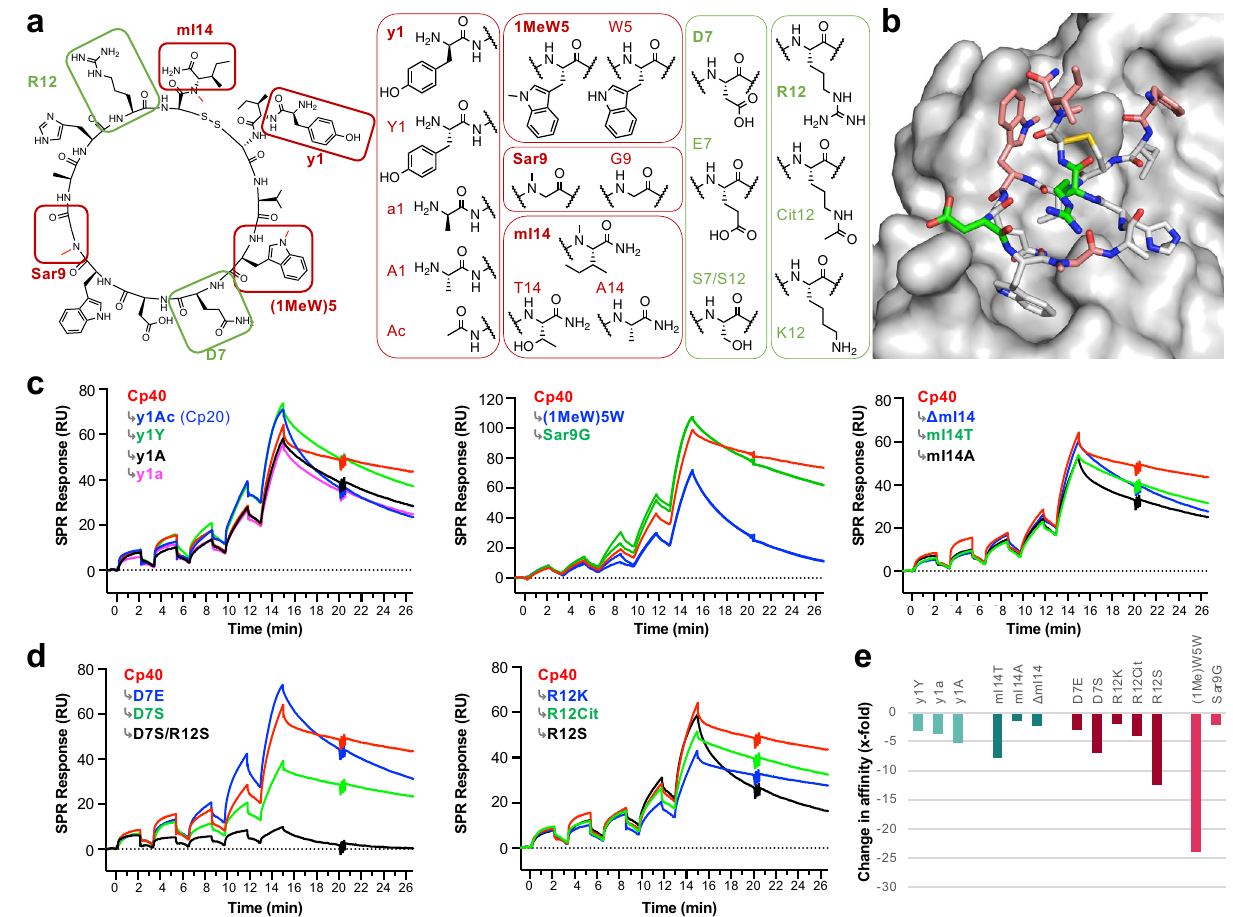
Fig. 4 | Structure-activity relationship study of the Cp40-C3b interaction. a Amino acid substitutions introduced for the study, with residues altered during leadoptimizationstepsframedinredandchargedresiduesingreen. b Localization ofthechangedresiduesonthecrystalstructureofCp40withC3bcolorcodedasin a . SPR sensorgrams of Cp40 and its site-speci fi cally mutated derivatives affecting the c optimized or d charged residues. Representative sensorgrams from at least